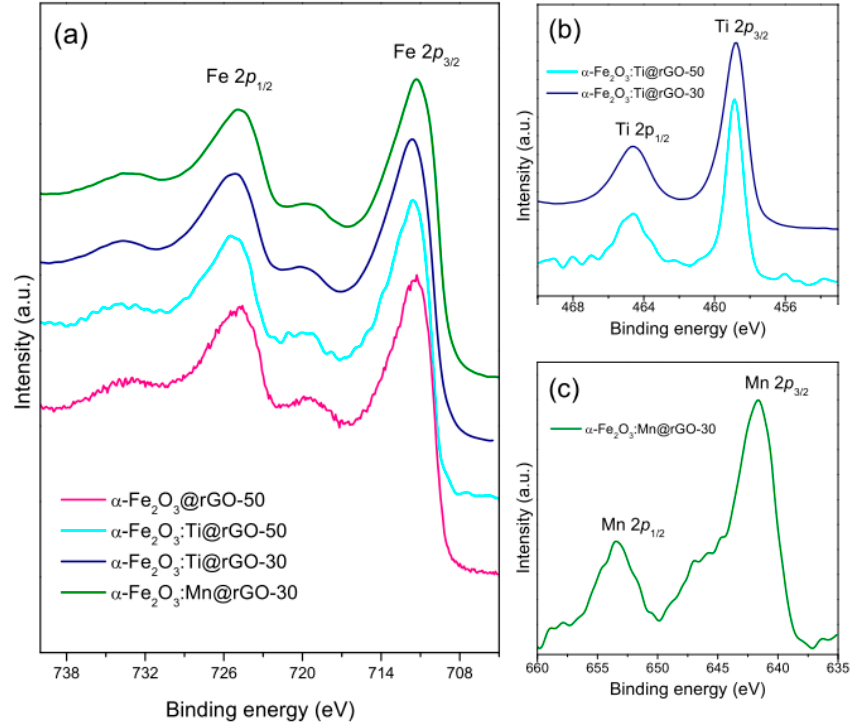
Figure 3. XPS spectra of ( a ) Fe 0 2 p , ( b ) Ti 0 2 p and ( c ) Mn 0 2 p core levels in the nanocomposites.